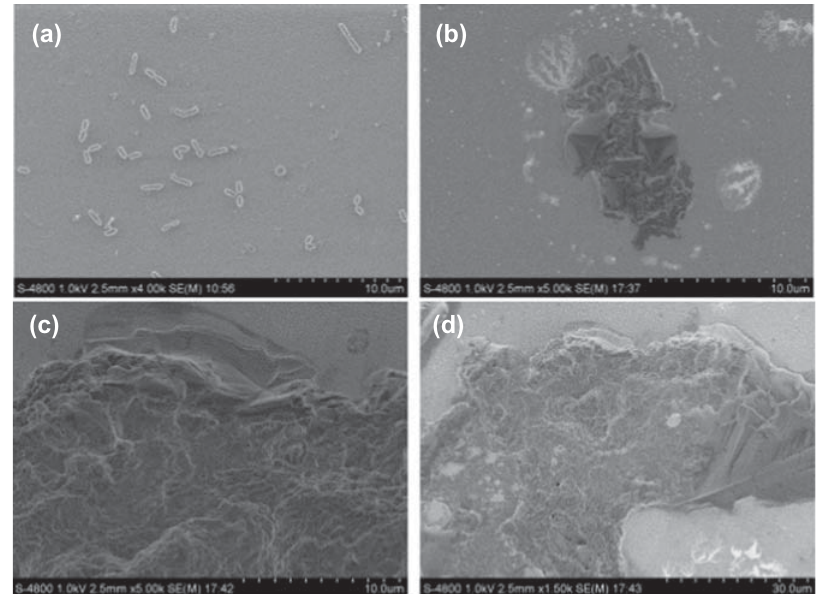
Figure 2: SEM images of B. subtilis cells after di ff erent adsorption time, including control group ( a ) , 15 min ( b ) and 90 min ( c and d ) .